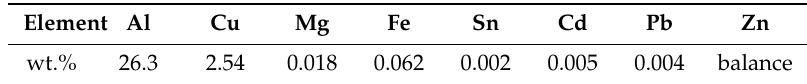
Table 1. The chemical composition of ZA27 alloy.